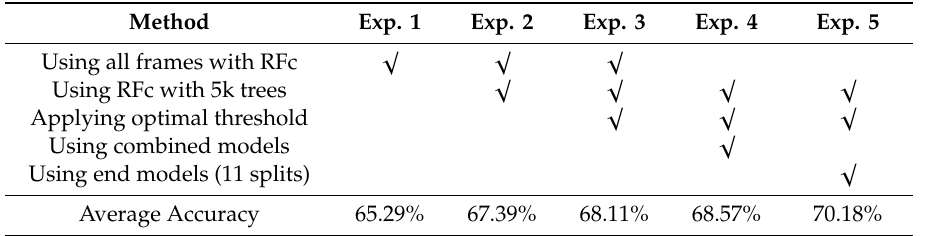
Table 4. An overview of the ablation studies of the proposed solutions, with each experiment using RFc with FF4. We conducted 5 experiments combining di ff erent methods (ticks display its usage) to improve the model’s performance. The results are the average accuracy of models obtained from cross-validation. Method Exp. 1 Exp. 2